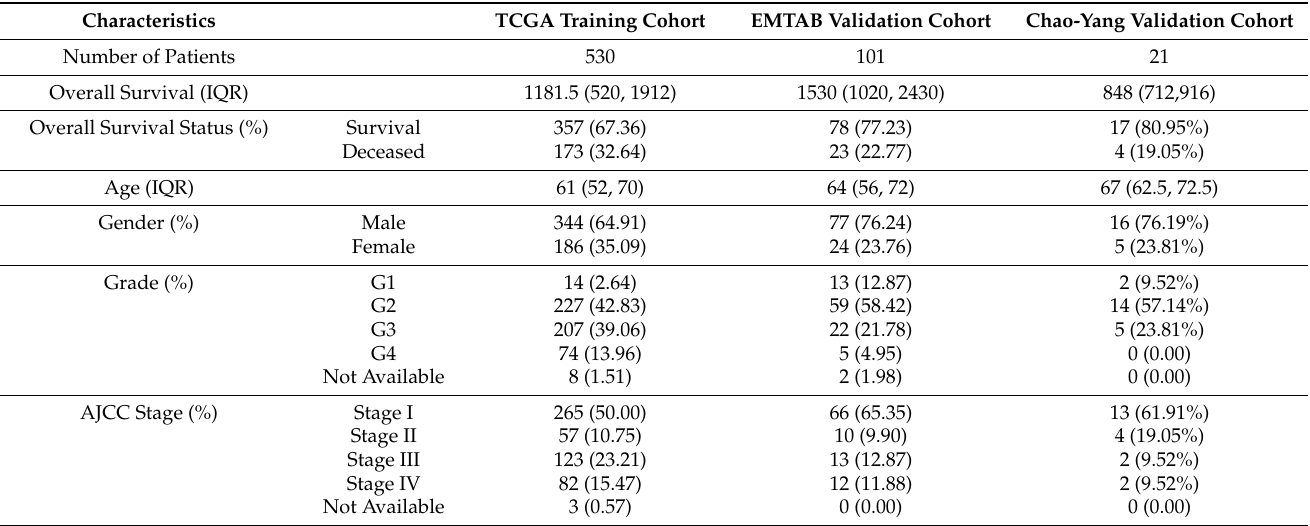
Table 1. Clinical characteristics of patients in the TCGA training, EMTAB validation cohorts and Chao-Yang clinical validation